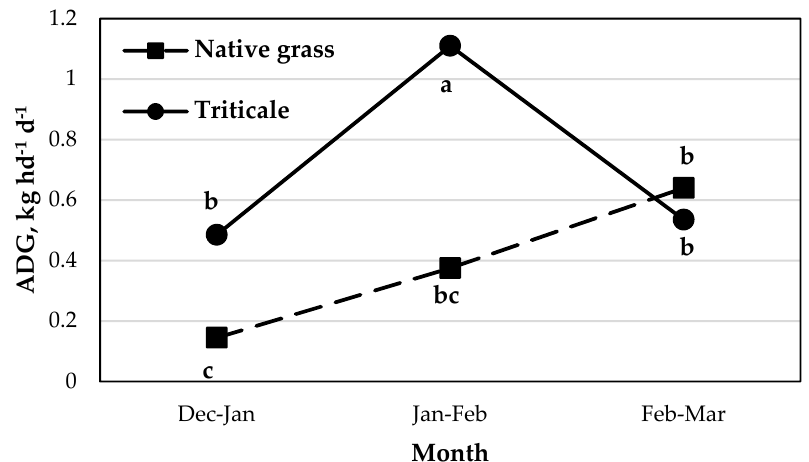
Figure 1. The pasture × month interaction for average daily gain (ADG) of stocker cattle grazing supplemented dormant native grass or triticale in 2014 at Tucumcari, NM, USA. For months on the x-axis, Dec-Jan, Jan-Feb, and Feb-Mar represent 20 December 2013 to 15 January 2014; 15 January to 12 February 2014; and 12 February to 14 March 2014, respectively. Values are the means of two pasture replicates. Letters indicate significant differences among all means in the interaction at p = 0.05 (standard error of the difference between means in the interaction = 0.13).